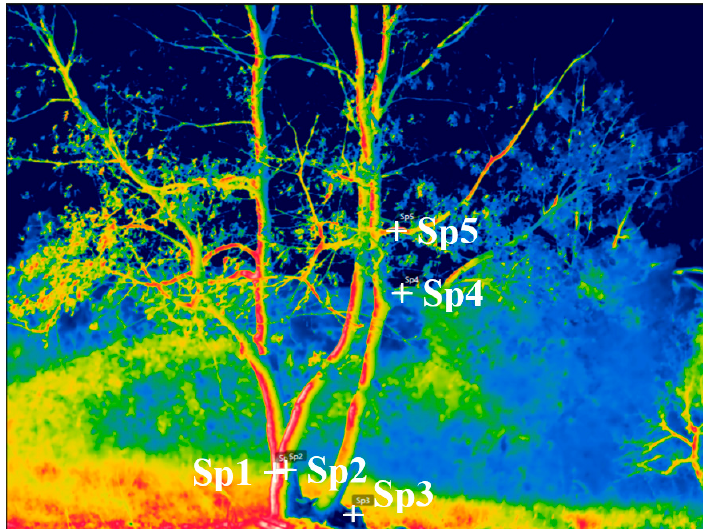
Figure 6. Thermogram of Quercus pyrenaica Willd tree taken at 2 p.m. under direct sunlight. (Spot’s size out of scale for better visualization).